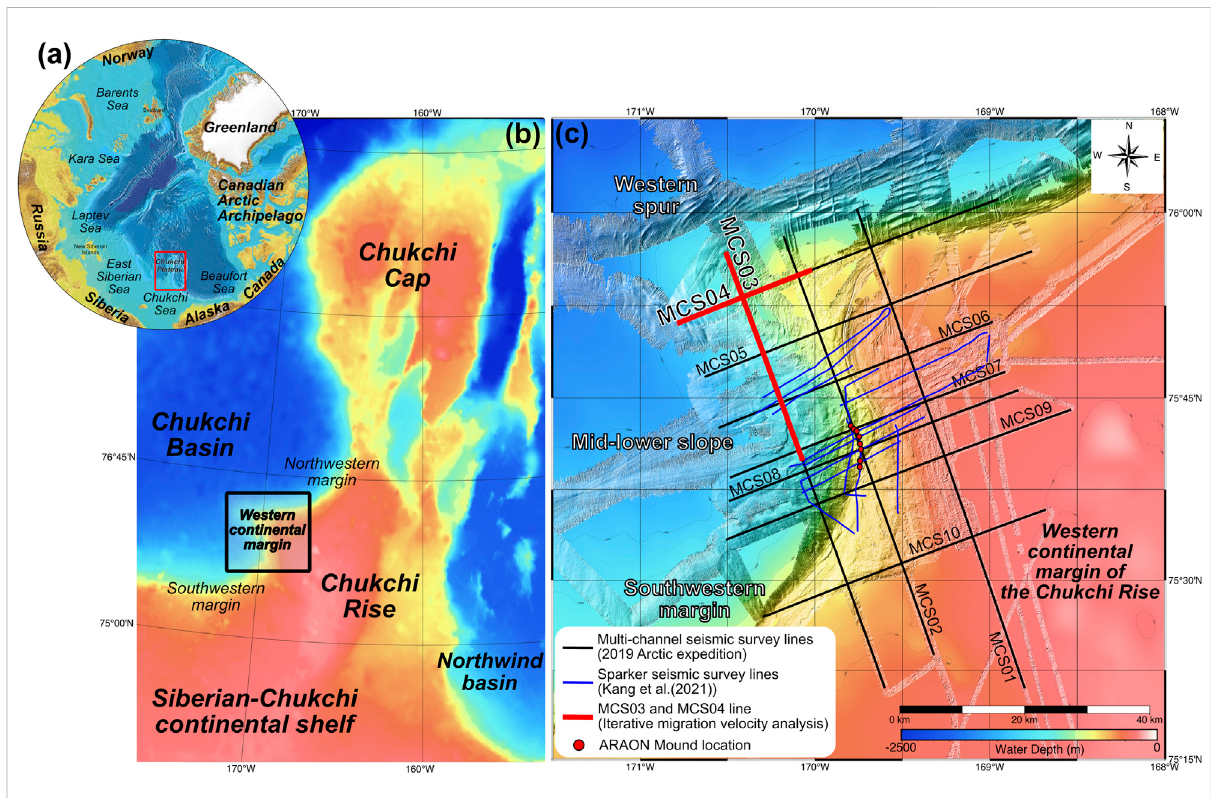
FIGURE 1 Map of the study area. (A) Bathymetric map of the Arctic Ocean. (B) is the map of the Chukchi Plateau, and the study area is located on the western continental margin of the Chukchi Rise (black box). (C) Map of the seismic track lines in the 2018 and 2019 Arctic